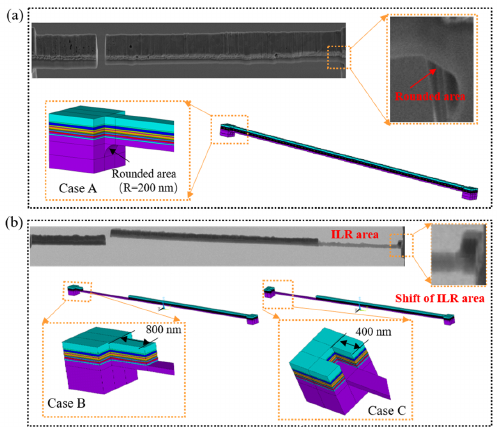
Figure 13. The SEM images and FE models of the micro cantilever beam with three kinds of machine errors: ( a ) rounded area; ( b ) shifts in the ILR area.